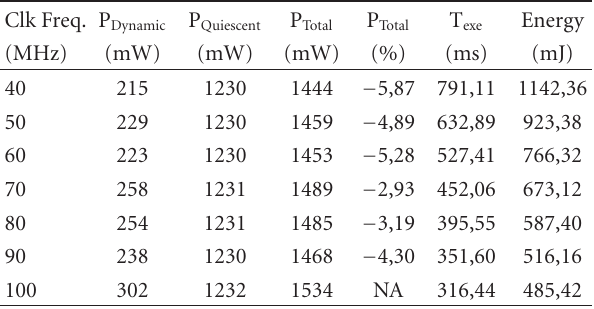
Table 4: Impact of the variation of the clock frequency onto the power consumption for V5LX110T.